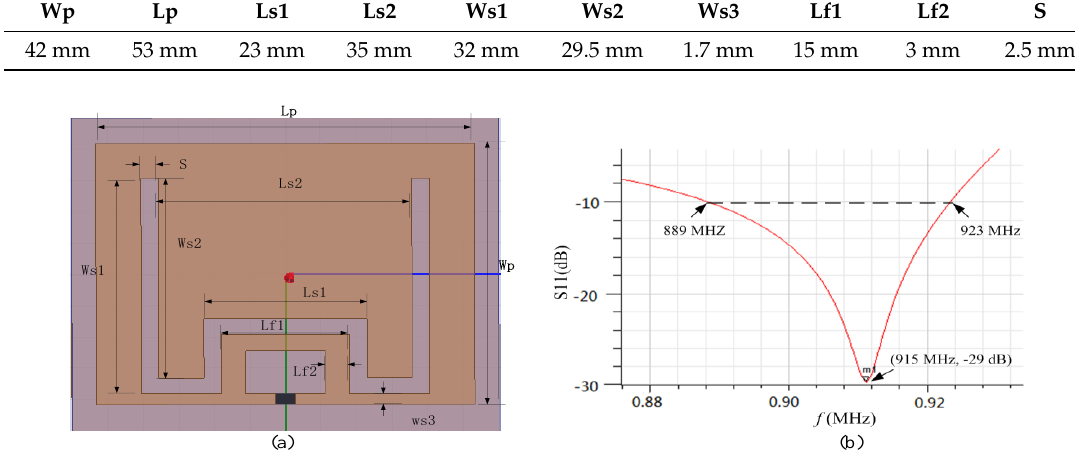
Table 1. Design parameters of the patch antenna.